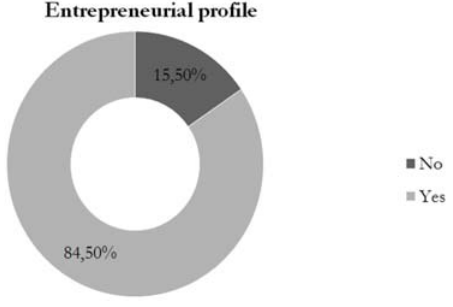
Fig. 1. Entrepreneurial profile of respondents